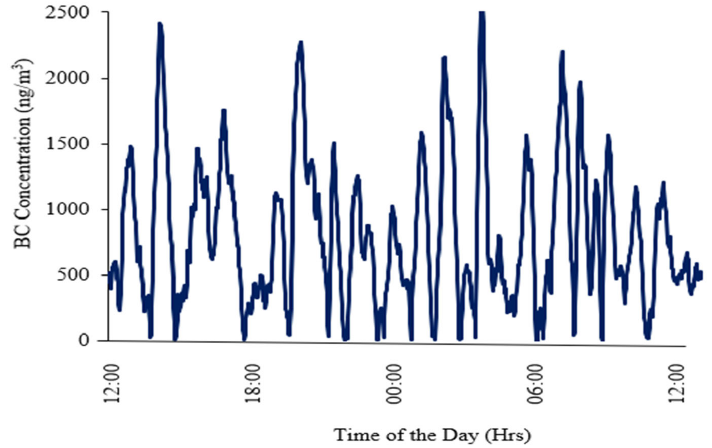
Figure 7. Variation of black carbon concentrations at the Port of Albany during 13 ‐ 14 November 2018 (weekday: Tuesday and Wednesday).